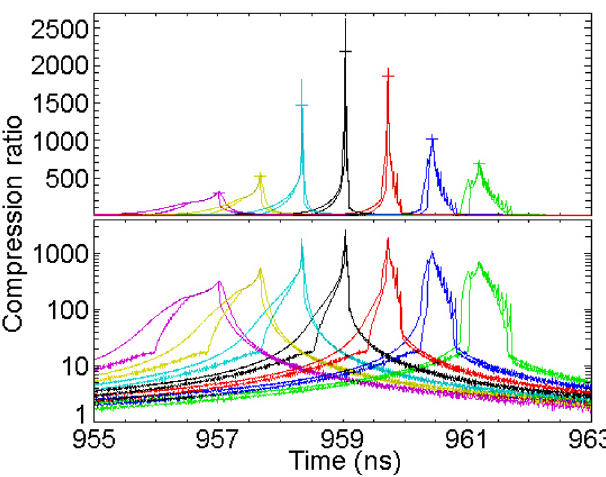
(cid:2) t (cid:3) =I FIG. 4. (Color) Compression ratio I comparison between b 0 smooth (top profiles) and sharp (bottom profiles) waveforms on linear (top) and log (bottom) scales in the laboratory frame at multiple axial locations near the focal plane ( z (cid:4) (cid:8) 59 : 5 cm ), in steps of (cid:1) z (cid:4) 0 : 1 cm . The initial T k (cid:4) 0 eV beams are tilted across the finite-size gap. Nonphysical horizontal bars are added on the linear scale plot to demarcate the excess compression in the smooth waveform case. The log scale plot shows the in- creased amount of current in the prepulse of the smooth wave- form case.